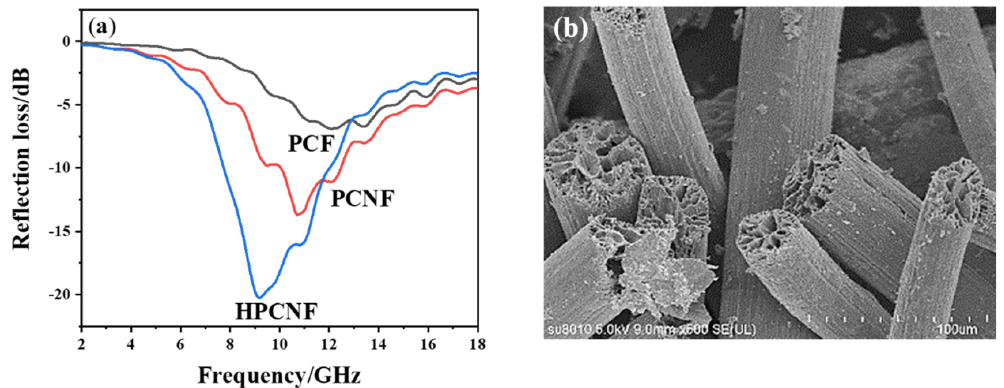
Figure 7. ( a ) The reflection loss of composites filled with different absorbents at the same content of 7%; ( b ) PCF morphology.